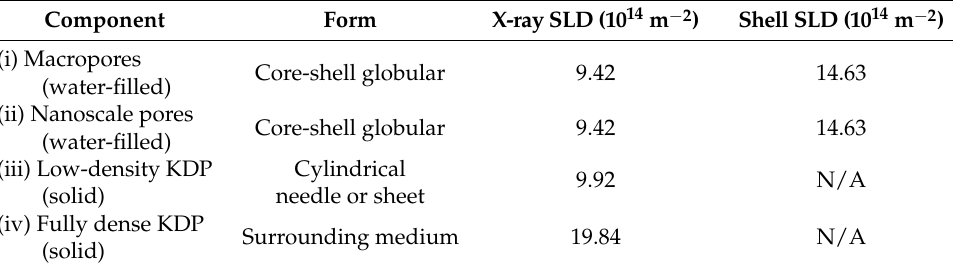
Table 1. Summary of microstructure assumptions for modeling and fitting in situ CSP USAXS/SAXS data 1